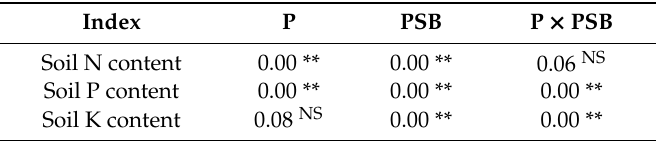
Table 4. Results of a two-way ANOVA of the effects of phosphate solubilizing bacteria (PSB) inoculation, phosphorus (P) application and their interactions on the soil parameters.